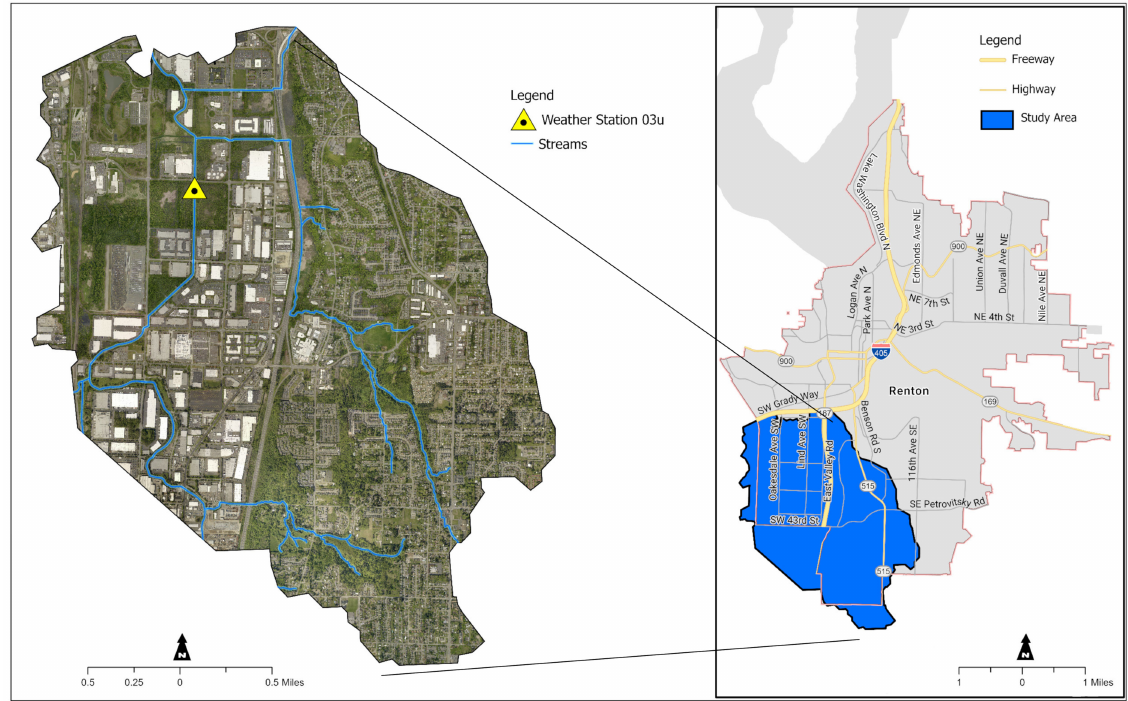
Figure 1. The study area (or City of Renton) with the weather station and Springbrook Creek that collects the stormwater from streets